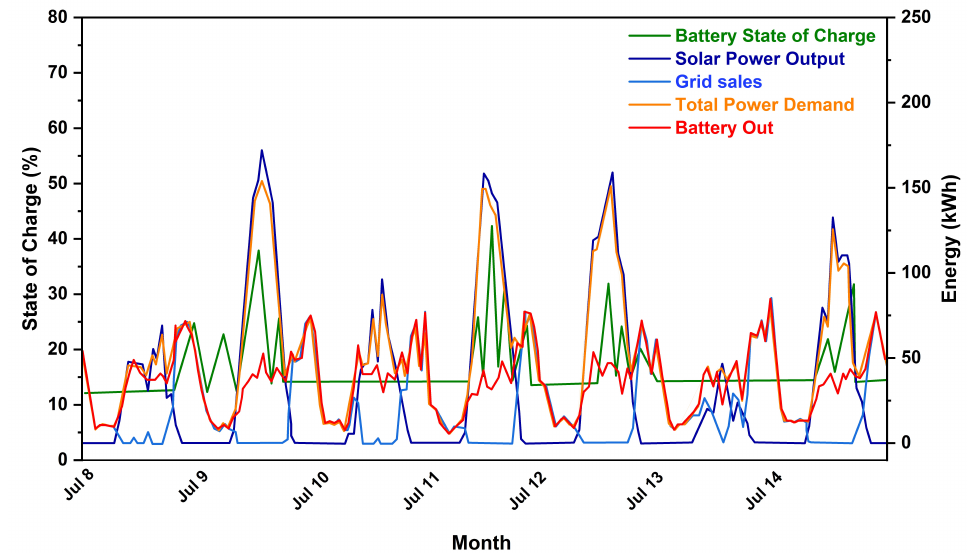
Figure 8. Battery SOC and energy balance of hybrid microgrid system for the third week of July.